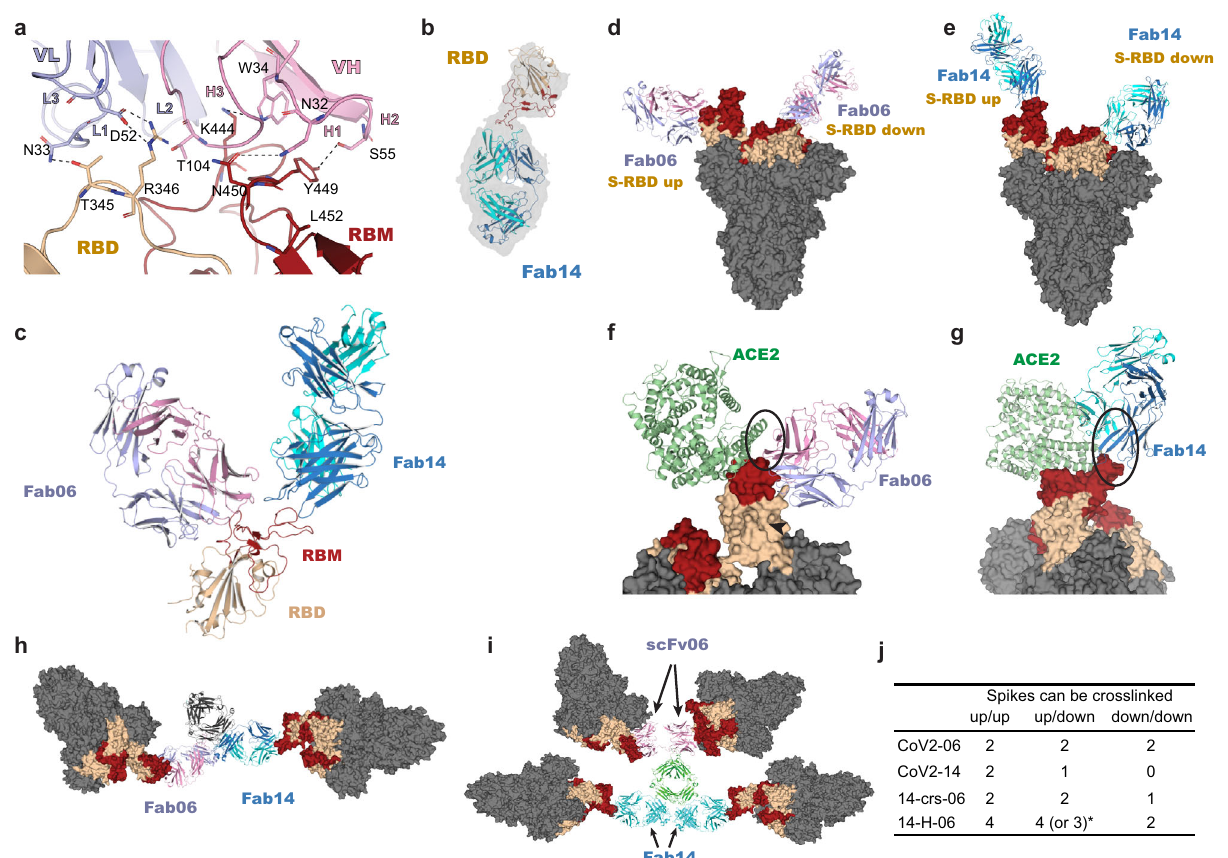
Fig. 3 | Binding models of cocktail antibodies and bispeci fi c antibodies. a Atomic details at the binding interface between Fab06 and RBD as revealed by X-ray crystallography. The VH and VL of Fab06 are colored in red and blue, respectively, and RBD is colored in yellow. Dashedlinesindicate polar interactions between Fab06 and RBD. b The Fab14/RBD complex was resolved by Cryo-EM, 3D reconstruction and model re fi nement. c The overall binding model of Fab06 and Fab14 on the RBD. The structural superposition of Fab06/RBD and Fab14/RBD complexes show the simultaneous binding of the Fab regions of CoV2-06 and CoV2-14. d , e , The binding modelsof Fab06( d )and Fab14( e )on the RBDofthe up or down conformations in the context of the spike trimer. f , g Structural super- position of Fab06/RBD and ACE2/RBD complexes f and Fab14/RBD and ACE2/RBD